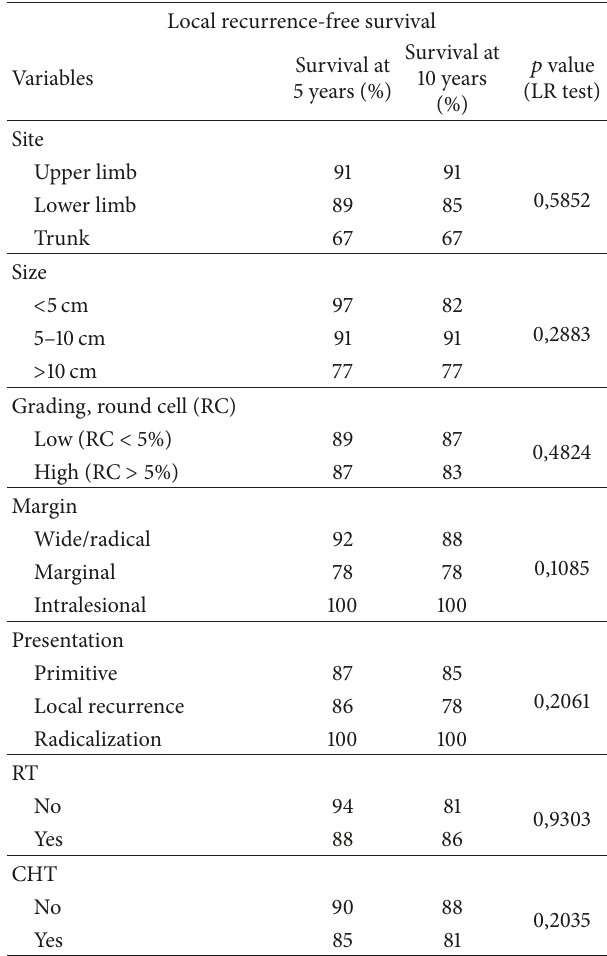
Table 3: Statistical analysis indicates that margins ( 𝑝 = 0.002 ), grading ( 𝑝 = 0,0479), and the metastasis ( 𝑝 < 0,001) are risk factors on overall survival (OS).